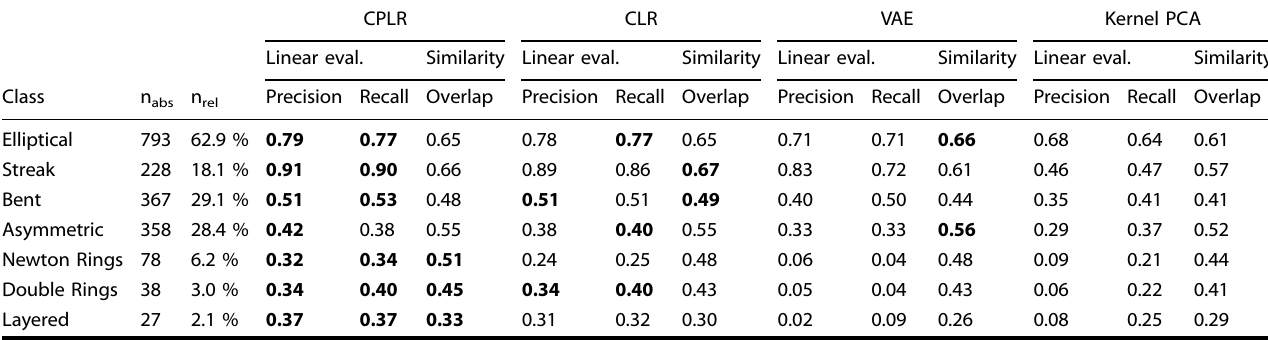
Table 2. Results for every class in the helium nanodroplets dataset. CPLR CLR VAE Kernel PCA Linear eval. Similarity Linear